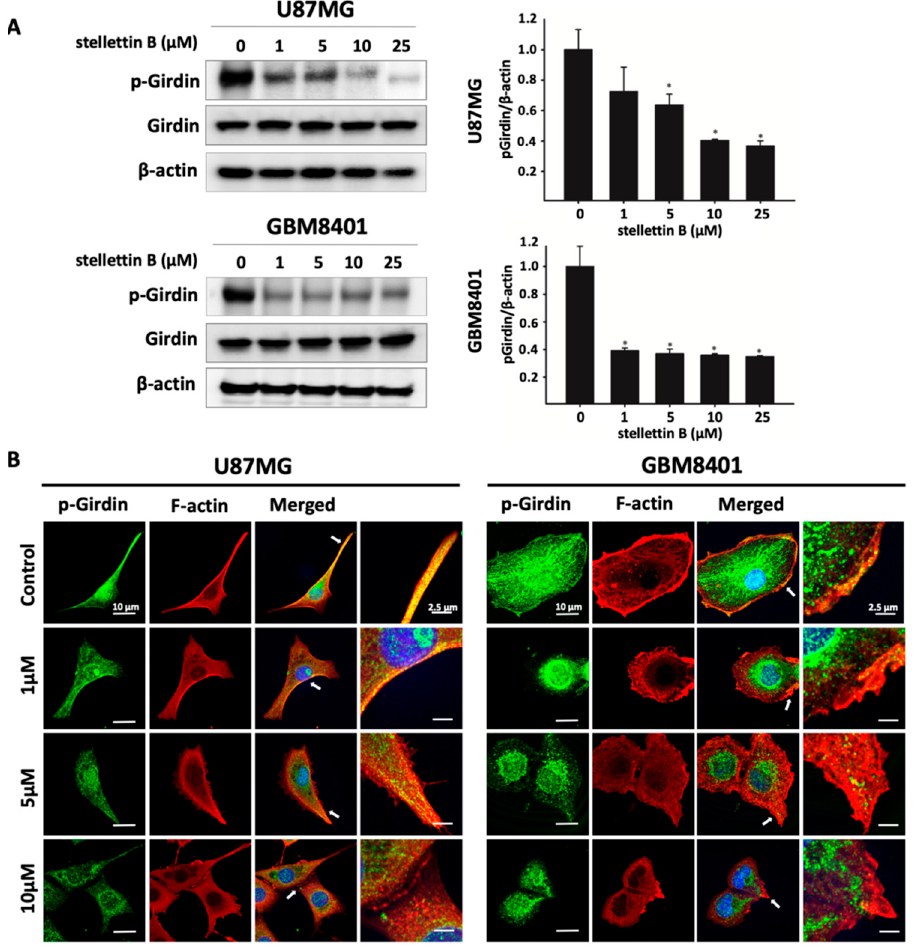
Figure 4. Stellettin B decreases p-Girdin and interacts with F-actin in glioblastoma cell edges. ( A ) U87MG and GBM8401 cells were treated with 0, 1, 5, 10, or 25 µ M stellettin B for 24 h. Western blot analysis was performed to study the expression of p-Girdin. β -Actin was used as a loading control. p-Girdin/ β -Actin were quantified. Values are expressed as the mean ± SD ( n = 3). * p < 0.05 relative to controls. ( B ) Confocal images of p-Girdin (green signals), F-actin (red signals), and nuclei (blue signals) in stellettin B–treated U87MG and GBM8401 cells. Scale bars: 10 μ m.